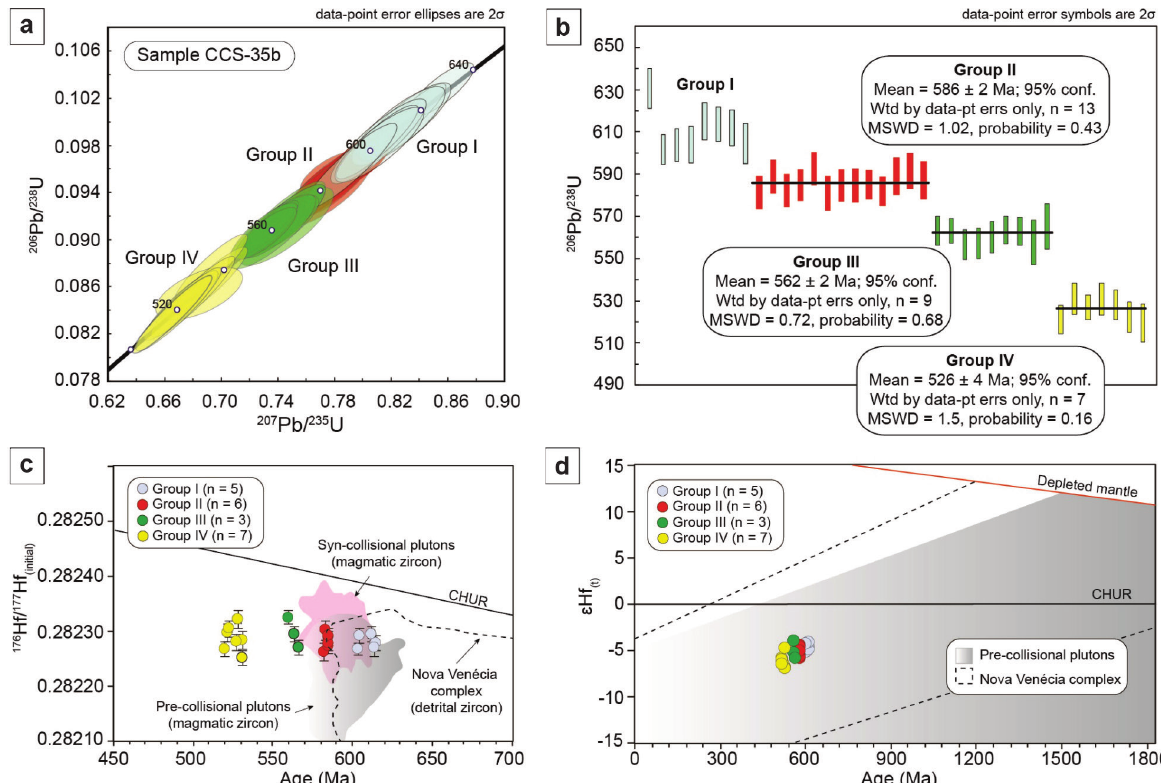
Figure 12. U-Pb ages and Hf isotopic composition for the Carlos Chagas Suite. (a and b) Concordia diagrams and weighted mean 206 Pb/ 238 U age plots containing the results of zircon U-Pb dating of the sample CCS-35b. (c) Initial 176 Hf/ 177 Hf ratios of zircon populations from the studied sample plotted against their age (Ma). The error bars are at 2σ level. (d) εHf vs. age diagrams for zircon grains this study. Data compiled from Gonçalves et al. (2016), Tedeschi (t) et al. (2016), Melo et al. (2017b) and Araújo et al.